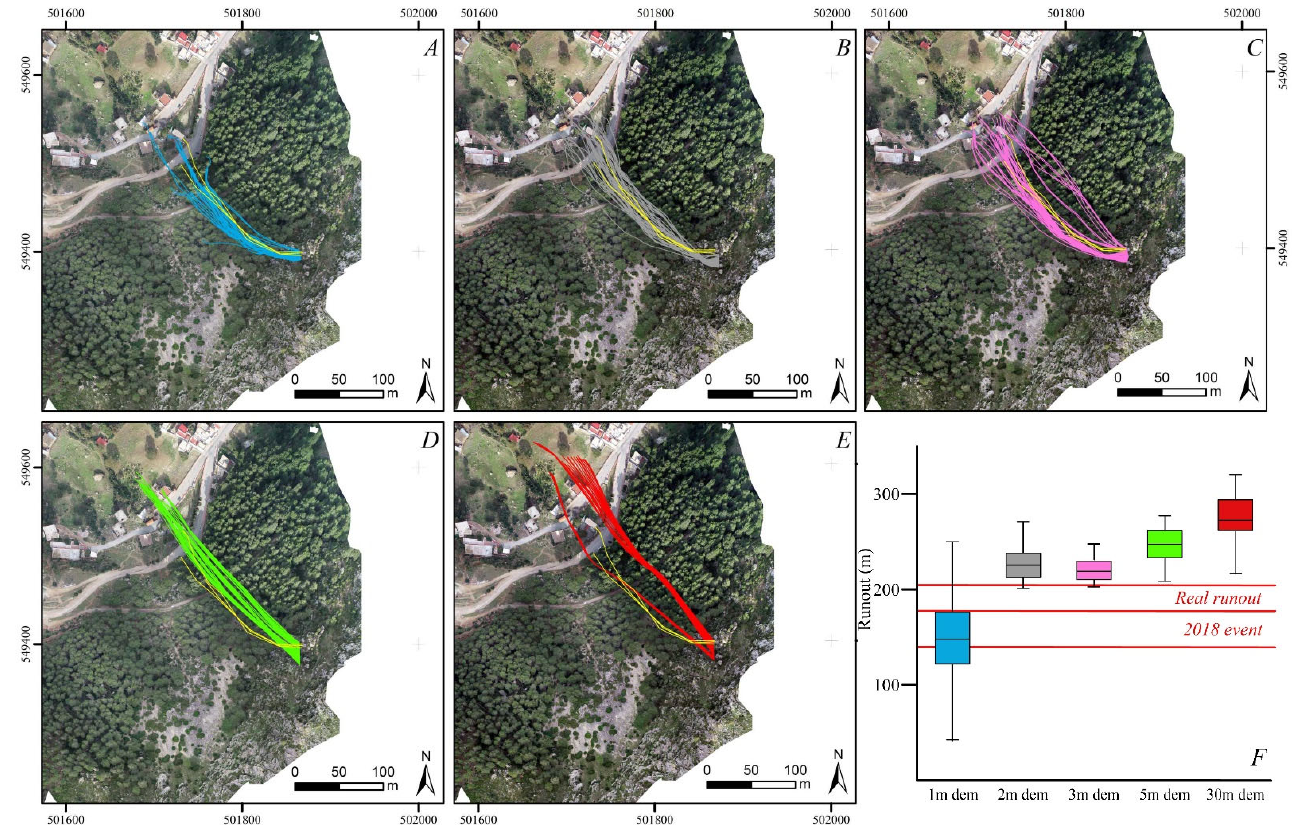
Figure 8. Simulated rockfall trajectories using the 1 m UAV ‐ derived DEM ( A ), the 2 m DEM ( B ), the 3 m DEM ( C ), the 5 m DEM ( D ) and the 30 m DEM ( E ). ( F ) Box plot of the runout distances obtained from the simulation models compared to the observed runouts of the 2018 event.